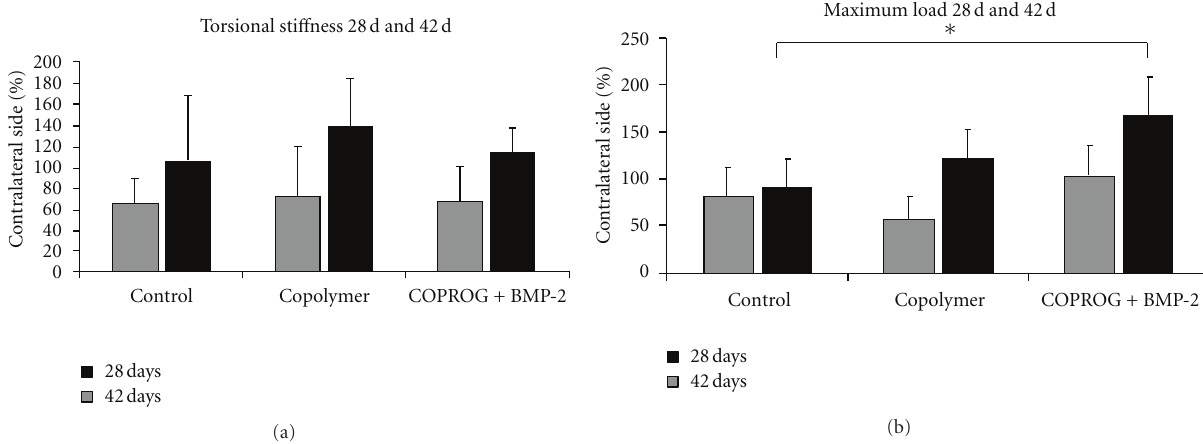
Figure 3: Biomechanical testing (torsional sti ff ness and maximum load of right rat tibia compared to those of the contralateral side). After 28 and 42 days the COPROG + BMP-2 group showed a significant higher maximum load compared to that of the control group (42 day period). ∗ P < 0 . 05 (ANOVA, Bonferroni). Table 2: Histomorphometric analysis of the tibial callus region after 28 and 42 days. There was significantly less mineralized area in the periosteal callus area in the COPROG + BMP-2 group compared to the control group at day 28 and no di ff erence in the other parameters between the groups at both time points. 28 days 42 days Control Copolymer COPROG + BMP Control Copolymer COPROG + BMP Mineralized Ar./Co.Ar (%) 97.9 ± 1.32 Periosteal Cl.Ar (Ti.Dm) (mm) 5.0 ± 0.88 Mineralized Ar./Ps.Cl.Ar (%) 77.9 ± 6.36 Cartilage Ar./Ps.Cl.Ar